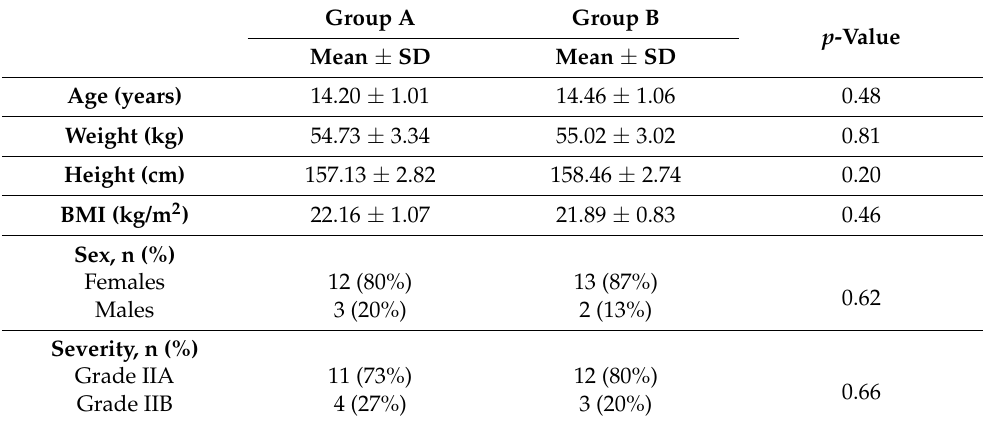
Table 1. Patients’